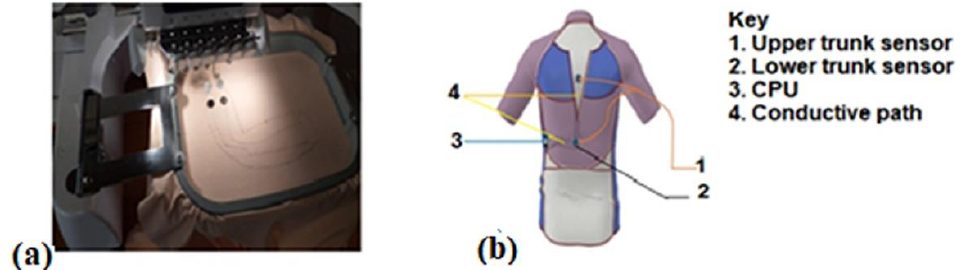
Figure 4. The embroidering process ( a ) and position of trunk monitoring sensors on to textile garments ( b ).